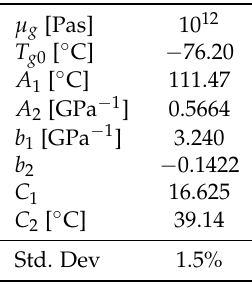
Figure 3. Viscosity pressure curves for [Choline] [Proline] at various temperatures. Table 2. Parameters of the Improved Yasutomi correlation for [Choline]